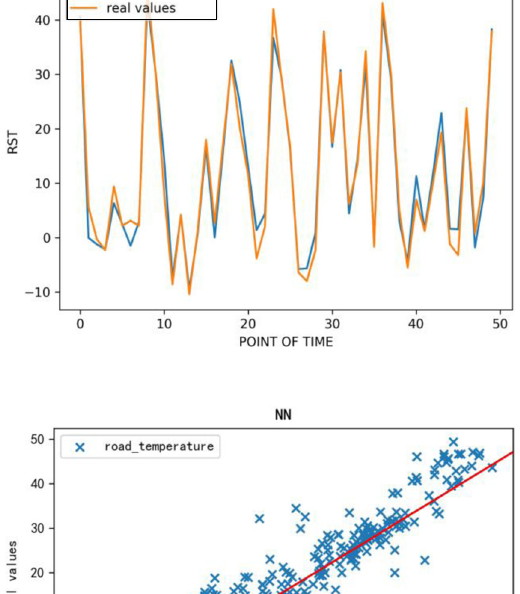
Figure 13. Regression plot for data samples with